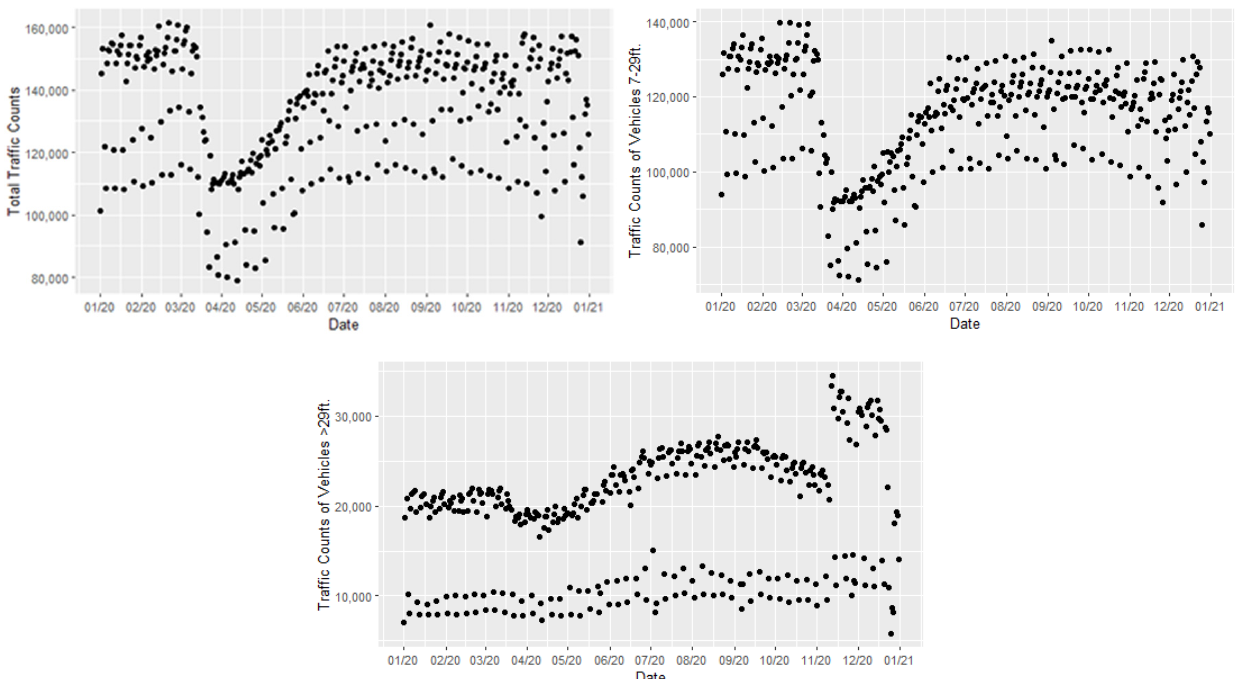
Figure 7. Predicted daily traffic counts at the Near Road site for each classification type (total traffic count, 7–29 ft, and >29 ft). The two trends are indicative of traffic volume variation between week-